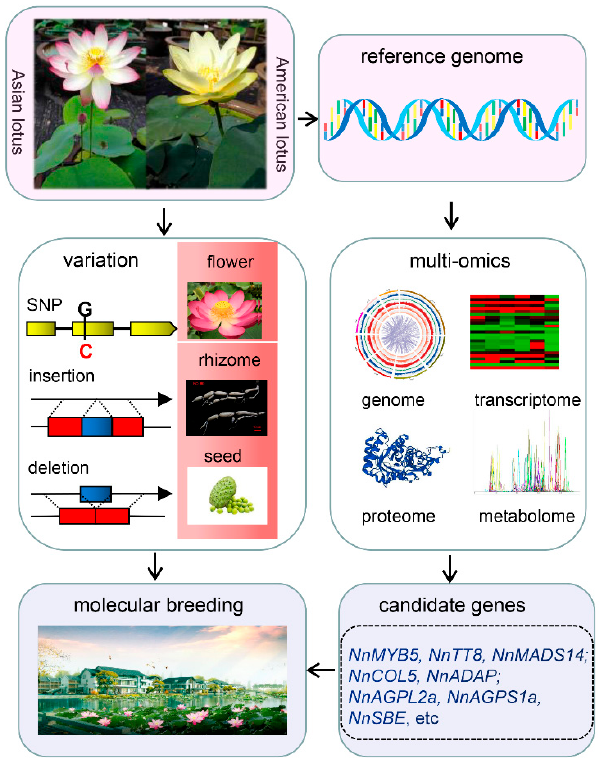
Figure 1. Flowchart of the molecular breeding process of lotus.